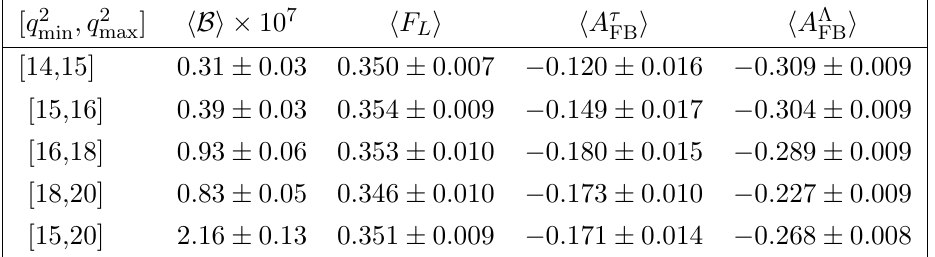
Table 1 . The total integrated branching ratio and the values of the observables in di(cid:11)erent q 2 bins (in GeV 2 ). The errors correspond to the uncertainties discussed in text.